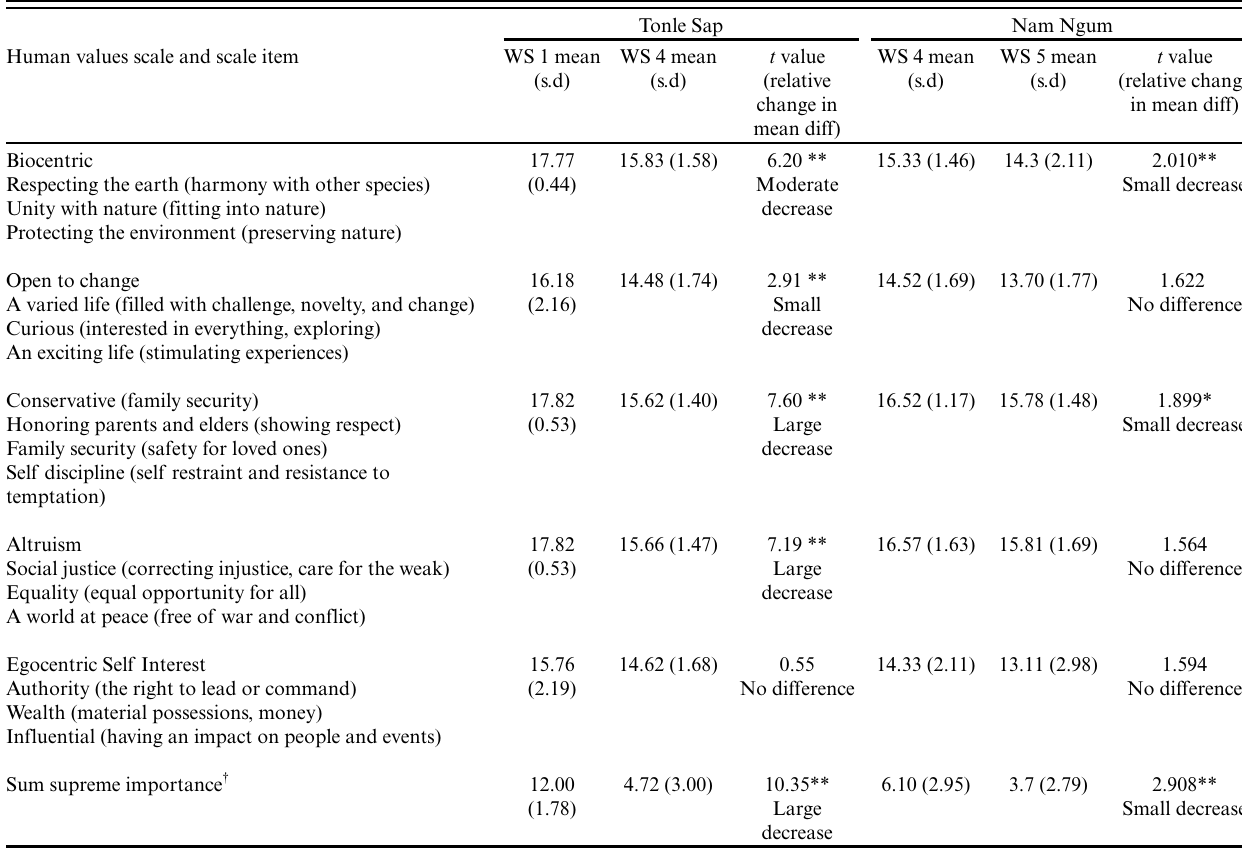
Table 1 . Comparison of the distribution of aggregated scale item scores: Tonle Sap workshop (WS) 1 compared with 4; and Nam Ngum workshop 4 compared with